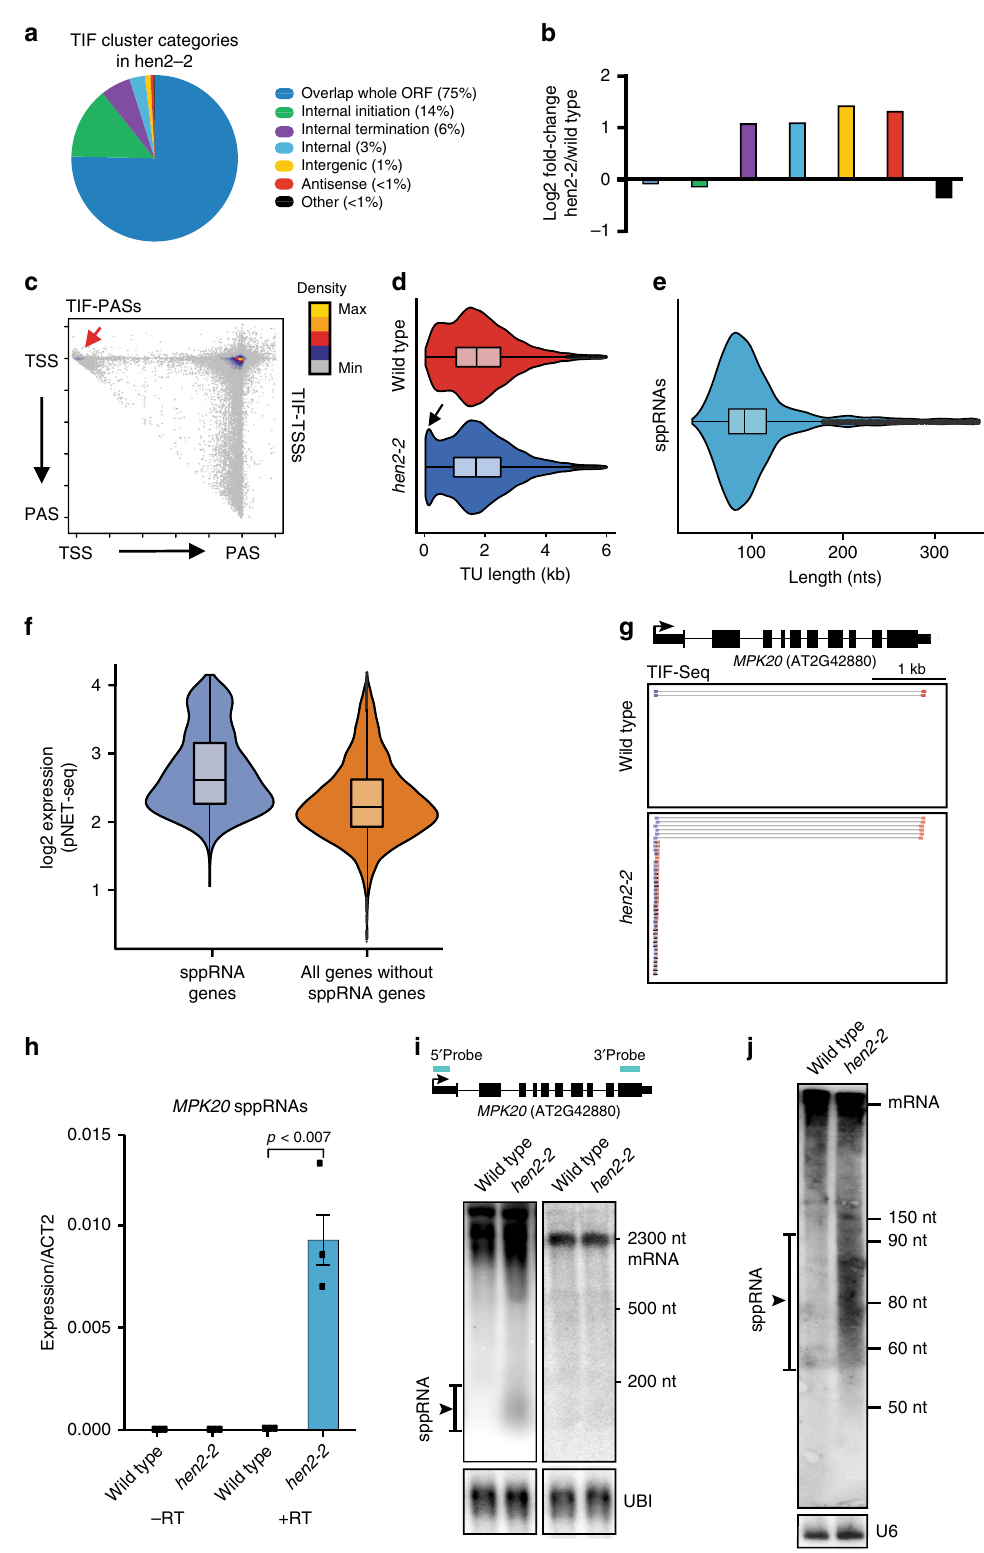
genes MPK20 and ACT8 contain prominent sppRNA. We quanti fi ed Yellow Fluorescent Protein (YFP) fl uorescence follow- ing transient expression in N. benthamiana leaves in constructs with wild-type 5 ′ -UTR sequence and mutant versions carrying deletions of the sppRNA sequences. Constructs carrying deletions